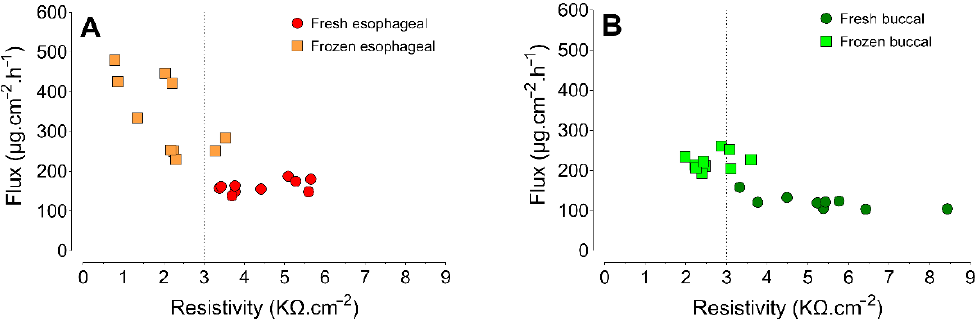
Figure 6. Correlation between steady-state flux and electrical resistivity, according to storage condition of ( A ) esophageal and ( B ) buccal epithelium.